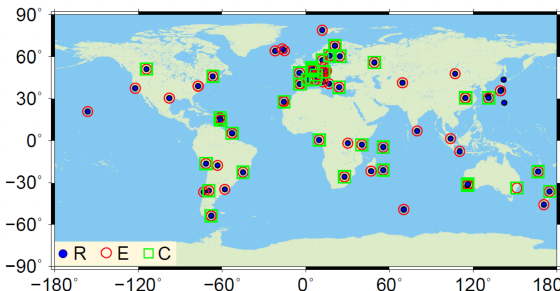
Figure 1. The geographical distribution of the MGEX stations and their supported navigation satellite constellations. R, E, and C refer to GLONASS, Galileo, and BeiDou, respectively, while GPS can be tracked by each